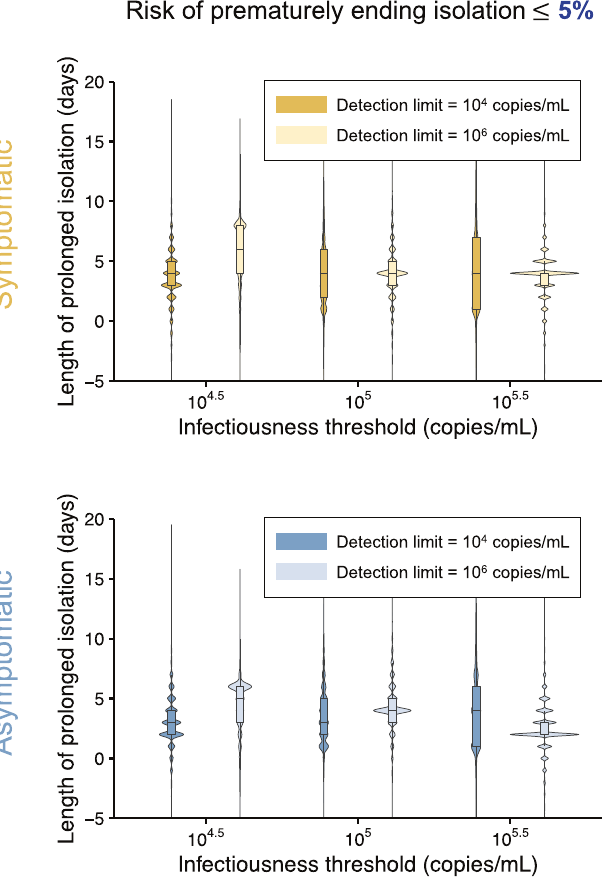
Fig.4|Comparisonbetweenthesituationsofhighandlowdetectionlimitsfor symptomatic and asymptomatic cases. a Distributions of length of prolonged isolation for different infectiousness threshold values, detection limits, and symptom presence when considering a 5% or lower risk of prematurely ending isolation. The violin plots show the kernel probability density, whereas the box plots show the median (50 percentile; bold lines) and interquartile ranges (25 and 75percentiles;boxes).Notethattheintervalbetweenantigentestsandthenumber